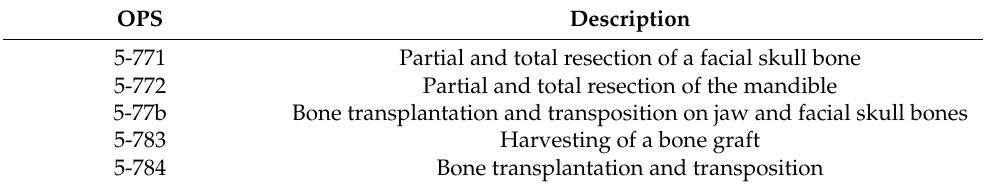
Table 1. Operation and procedure